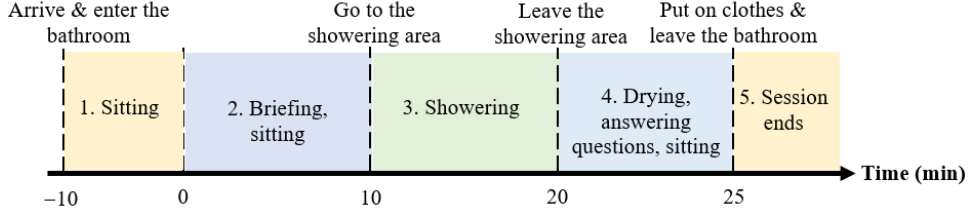
Figure 2. Experimental procedure.